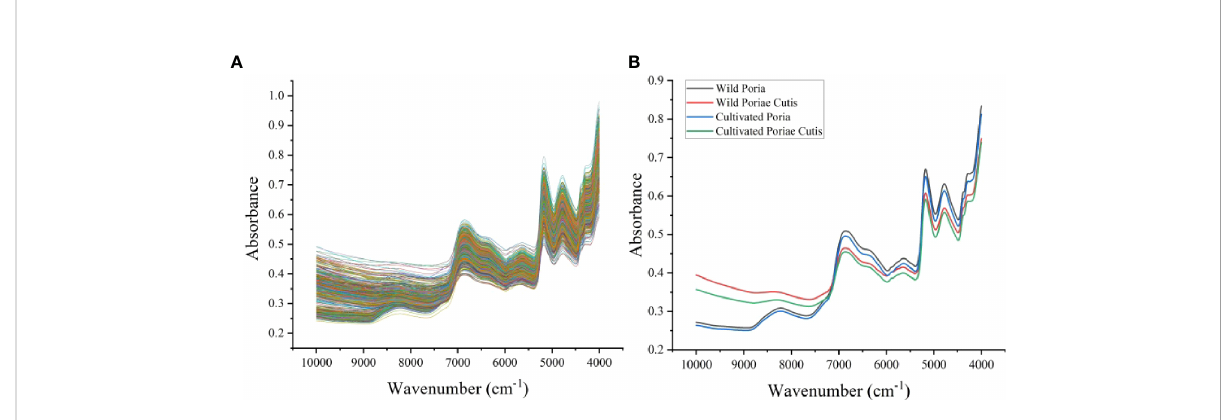
FIGURE 1 Spectra of samples: (A) raw spectra, (B) average